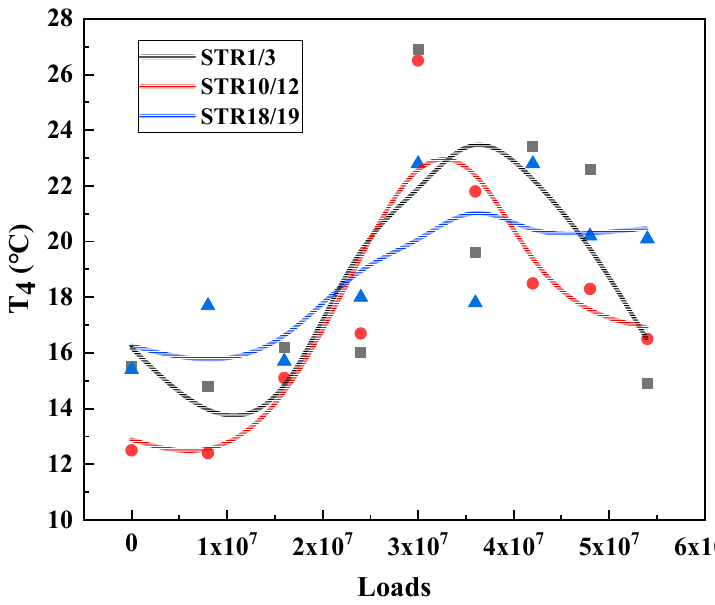
Figure 16. Characteristic temperature T 2 for the three types of structures.